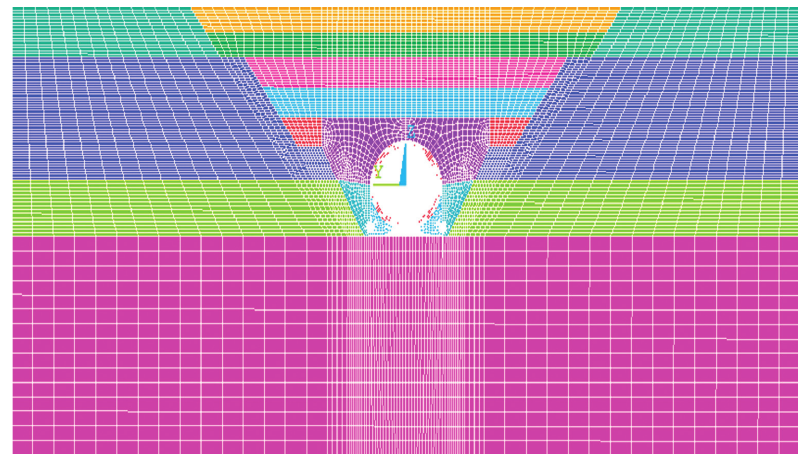
Figure 11: Overall model of the soil layer and prestressed culvert